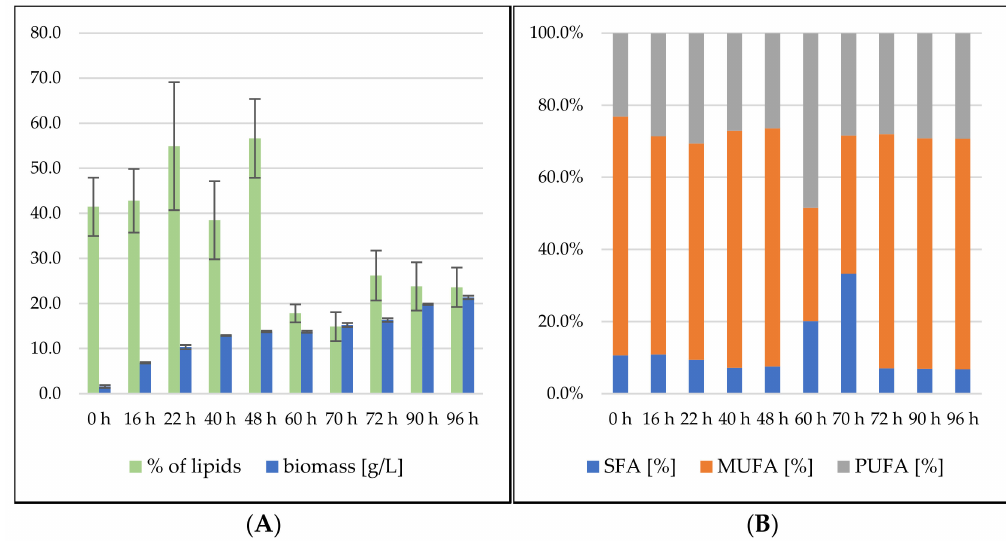
Figure 8. Sporidiobolus pararoseus bioreactor cultivation on SCG hydrolysate + waste frying oil. ( A ) Biomass production (g/L) and total lipid production (%); ( B ) Fatty acid profile (%).